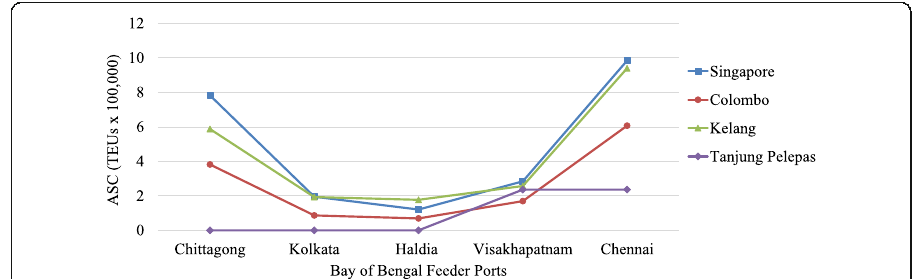
Fig. 4 Annual Slot Capacities of Common Services Calling Hub and Feeder